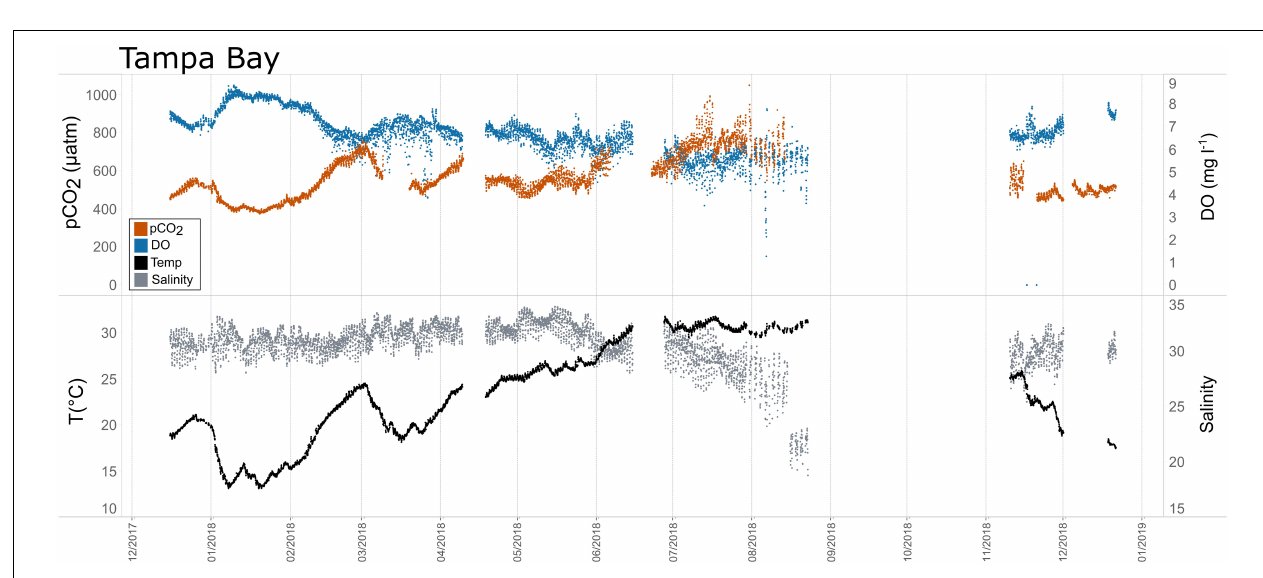
FIGURE 9 | Time series plots of partial pressure of carbon dioxide ( p CO 2 ), dissolved oxygen (DO), temperature, and salinity in Tampa Bay (December 2017–January